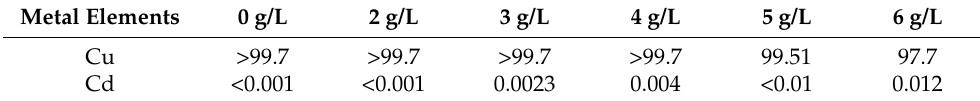
Table 2. Copper purity of cathode with different Cd 2+ concentrations in the second stage. Metal